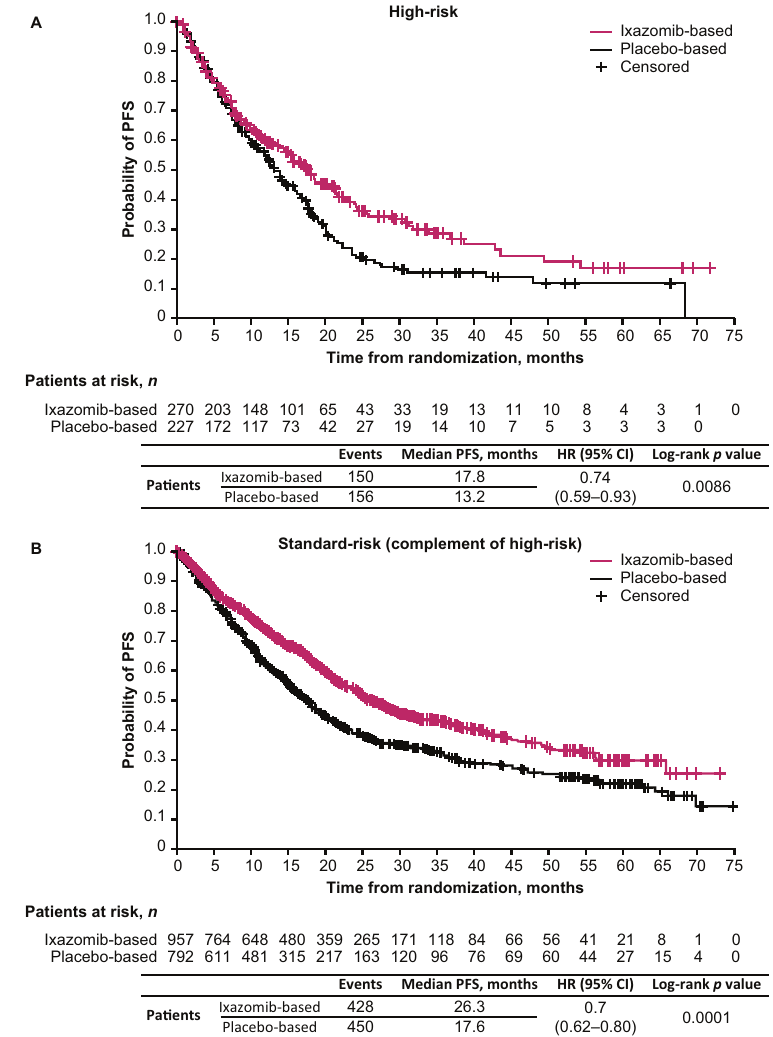
Fig. 2 Kaplan – Meier estimates of PFS for patients with high- or standard-risk cytogenetic abnormalities receiving ixazomib- vs placebo- based therapy. A High-risk cytogenetic abnormalities, and B standard-risk (complement of high-risk) abnormalities. CI con fi dence interval, HR hazard ratio, PFS progression-free